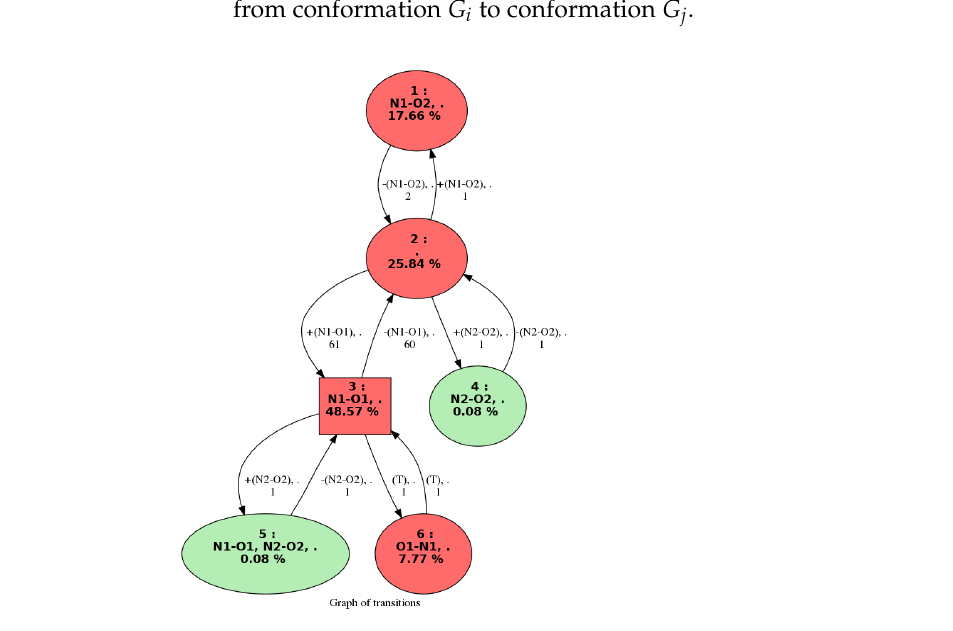
− Ala − COOH (C 2 6 H 13 N 2 O 3 ) 3